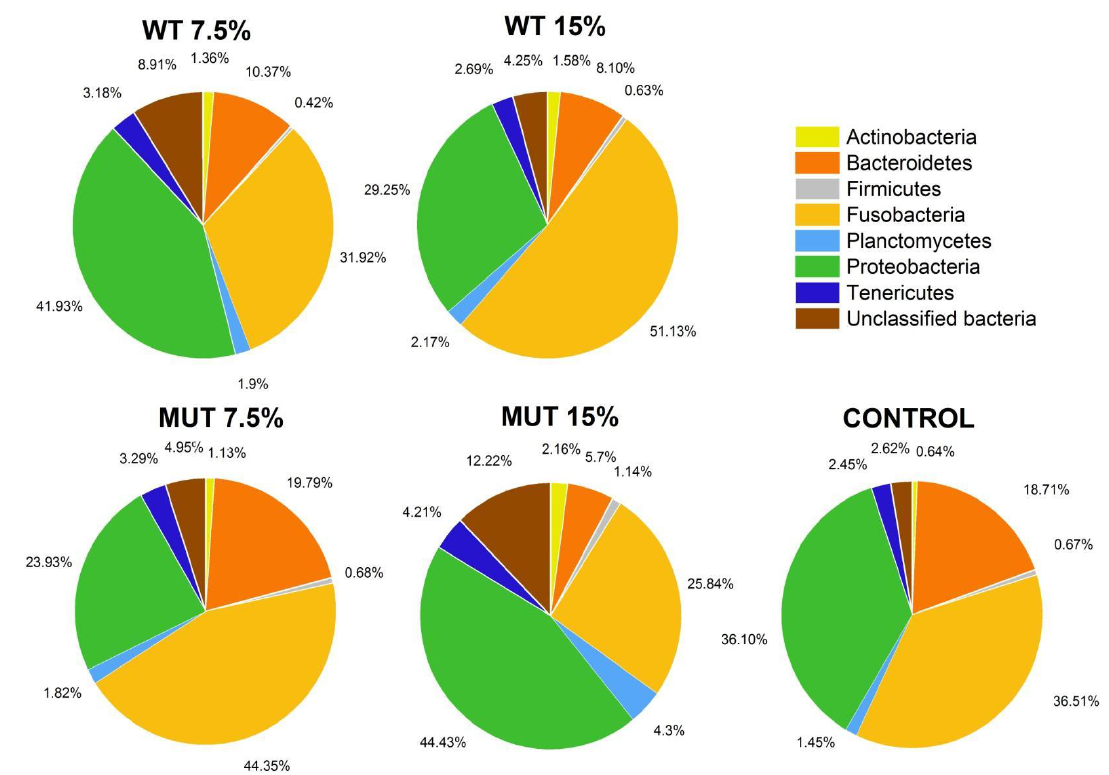
Figure 8. Relative abundance of the major bacterial phyla (>10% of total abundance) in the gut of zebrafish fed the different diets. Values for average relative abundance (%) of the eight most abundant phyla obtained after taxonomic assignment of bacterial 16S rRNA gene sequences. Each phylum is indicated by a different color. Control, nonsupplemented diet; WT, diet supplemented with wild-type Lobosphaera incisa ; MUT, diet supplemented with mutant strain of L. incisa .